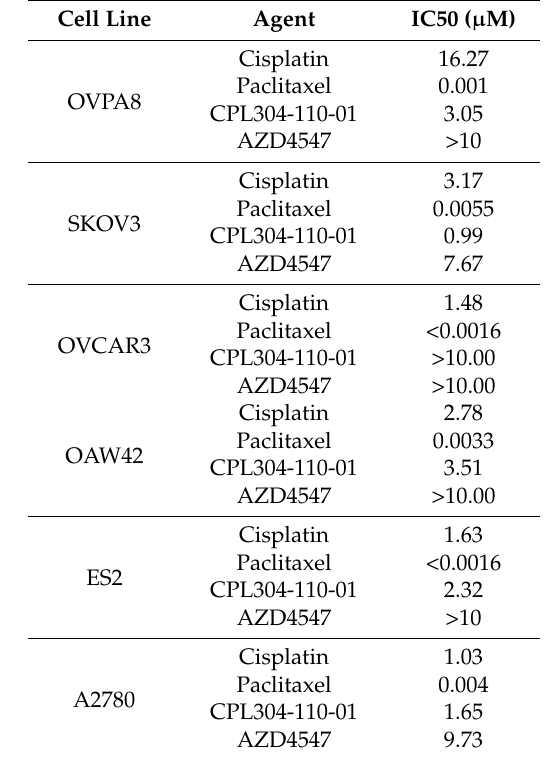
Table 2. Drug sensitivity of OVPA8 and other ovarian cancer cell lines. Cytotoxicity of cisplatin, paclitaxel and two different FGFR inhibitors was tested and IC50 values were calculated using GraphPad Prism software